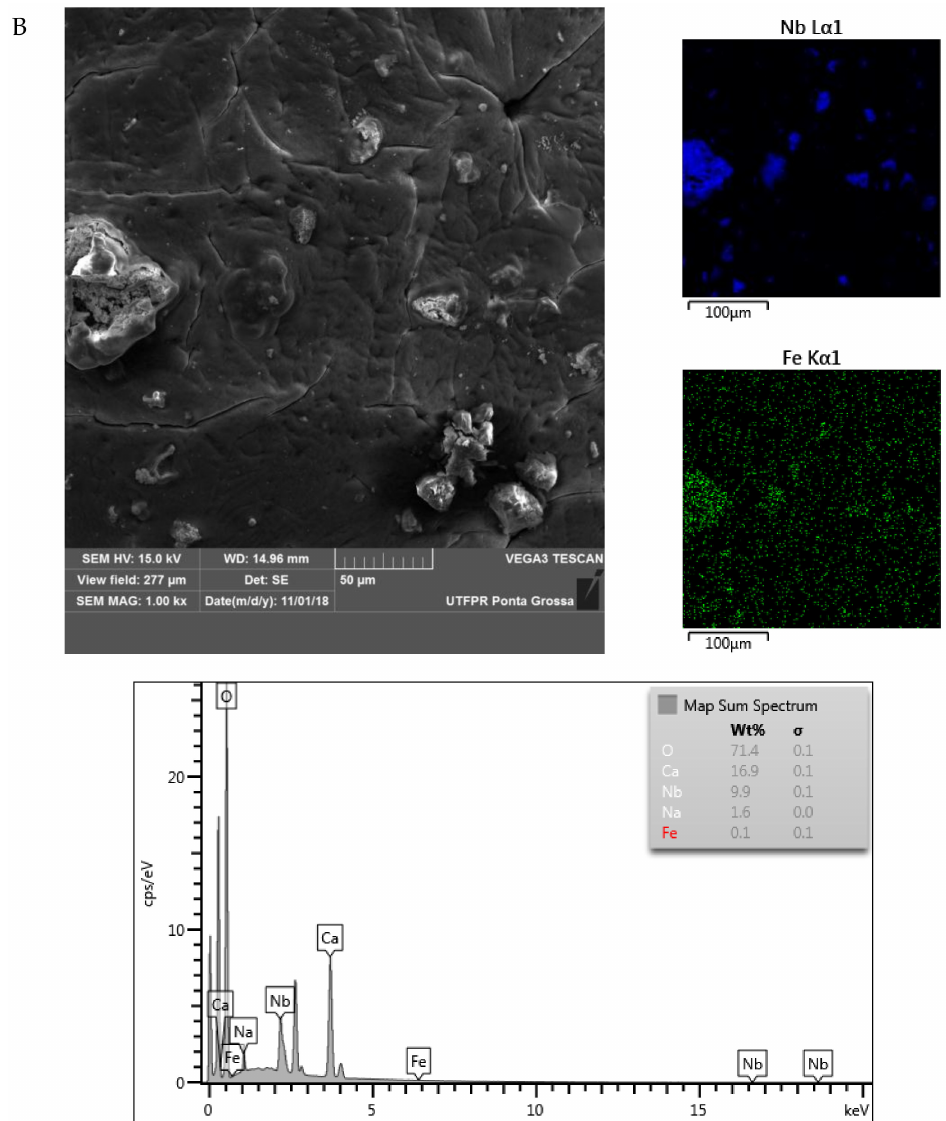
Figure 2. MEV/EDS of sample ( A ) 0.3% Fe/Nb 2 O 5 773 K, ( B ) 1.5% Fe/Nb 2 O 5 at 873 K, increase 500 ×